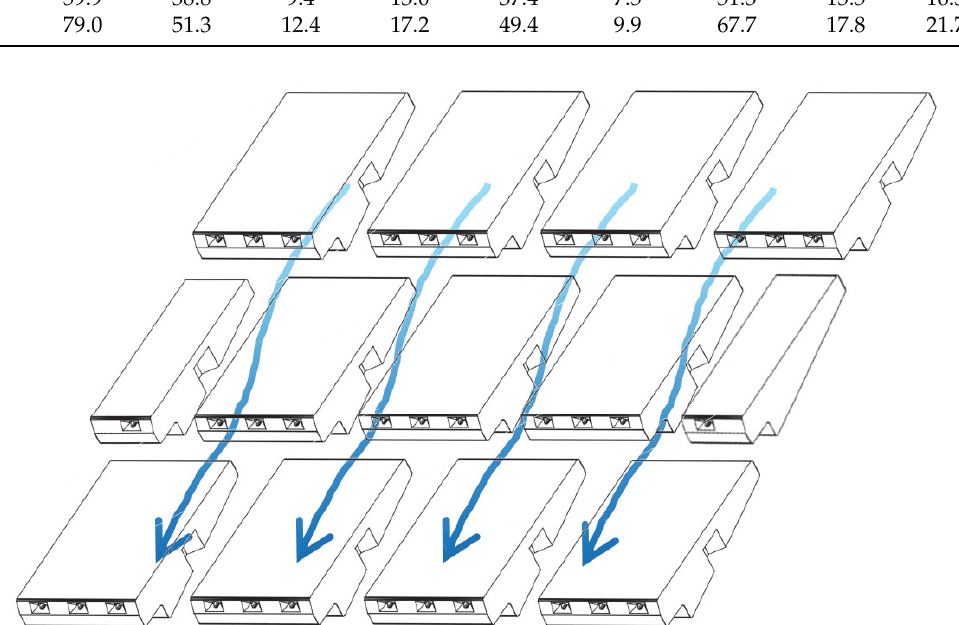
Figure 9. Picture of the intermediate wall dividing the two areas with different WSB sizes and eye- bolts installed on some of the WSBs for block-extraction tests. In the first test session, small and medium WSBs were used. The small WSBs were placed along the right half of the test channel in 80 rows, plus 1 end with trimmed blocks for the upstream row. In total, there were 440 WSBs, 80 half-blocks, plus 6 blocks for the upstream row (row# 81). Medium WSBs were placed in 53 rows, plus an additional row at the upstream end with trimmed blocks. In total, there were 186 WSBs, 52 half-blocks, and 3 blocks, plus 2 half-blocks, for the upstream row (row# 54). Additionally, an eyebolt was installed on some WSBs for block extraction tests (Figure 9). The pieces to be extracted were in the central block of six selected rows and distributed along the channel in rows #16, #26, #36, #44, #54 and #64 for the small blocks, and #10, #18, #24, #30, #36 and #42 for medium blocks. In the second set of tests, the small and large blocks were installed. The small WSBs were the same ones used in the first session as they remained in place after the first session without apparent damage. The large WSBs were placed in the left half of the test channel in 40 rows, plus one at the upstream end with cut blocks for top finishing. In total, 100